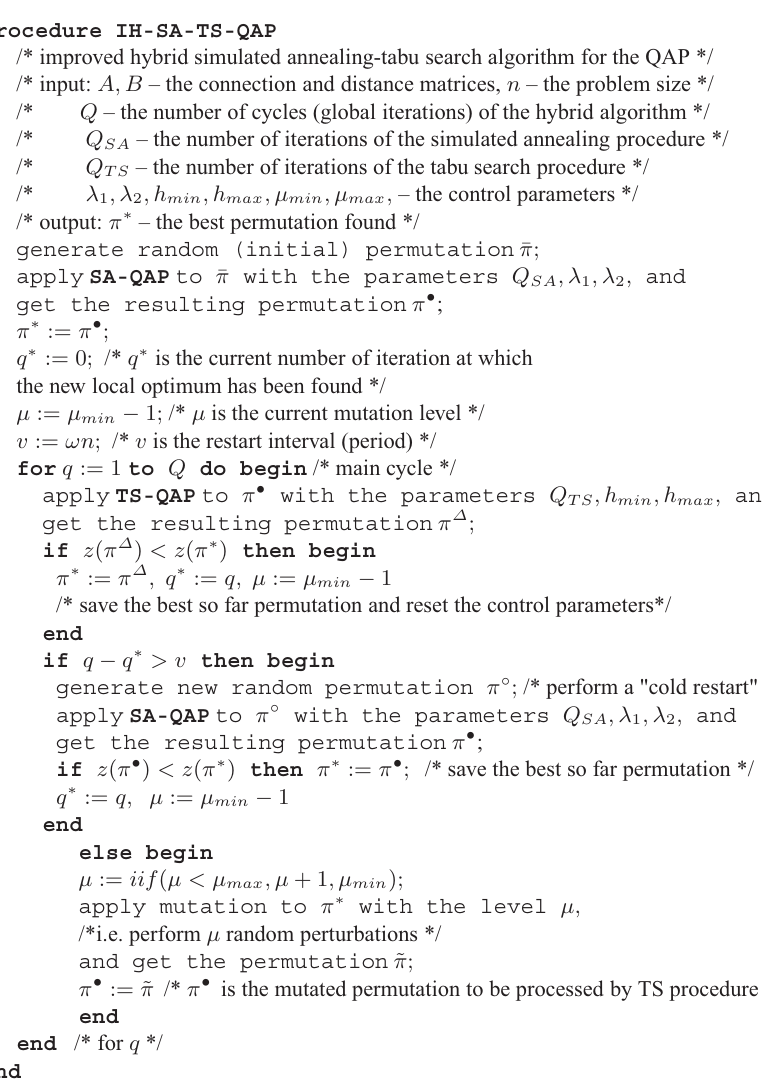
Figure 12. Pseudo-code of the improved hybrid simulated annealing and tabu search algo- rithm for the